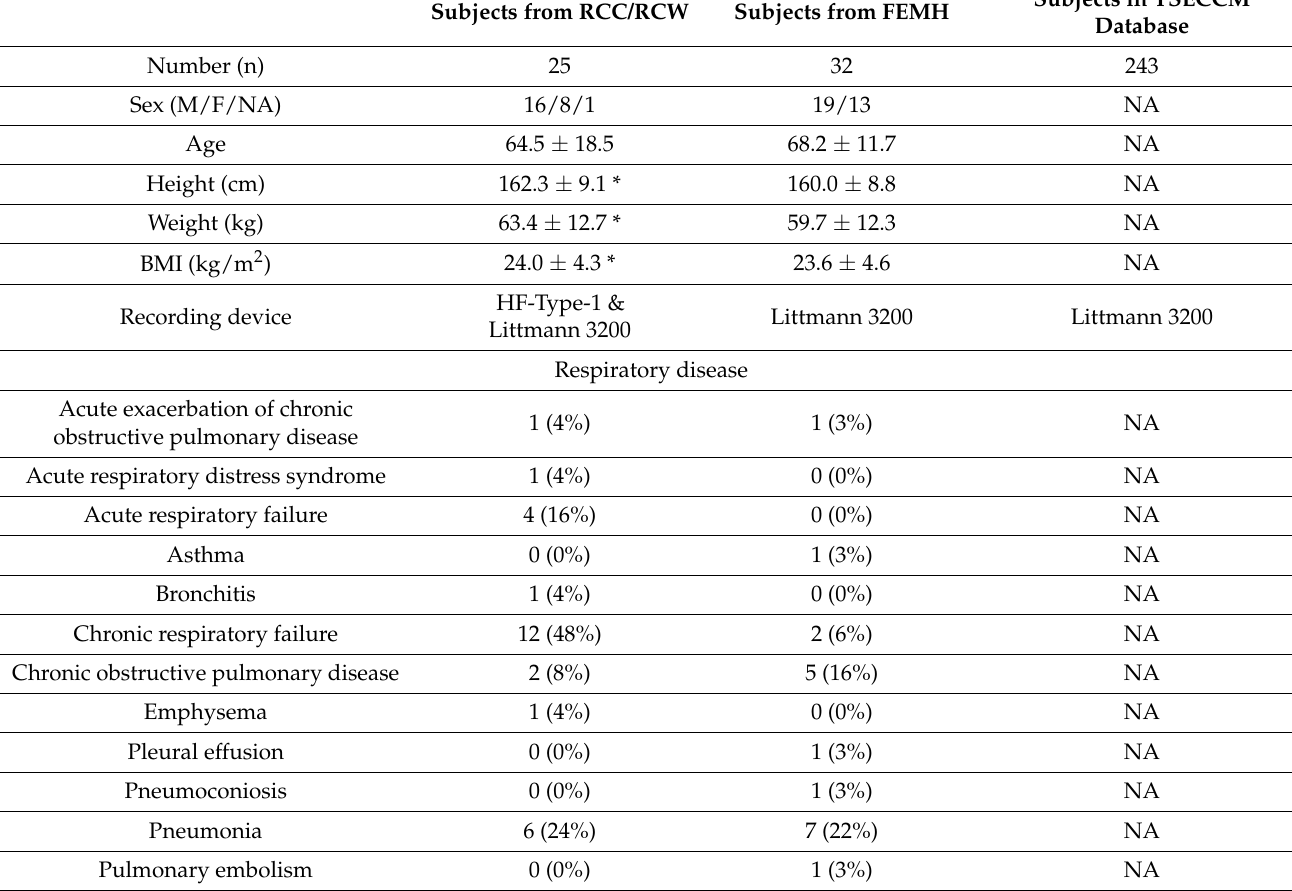
Table 1. Demographic data and the characteristics of respiratory diseases of the subjects in HF_Lung_V2. Subjects from RCC/RCW Subjects from